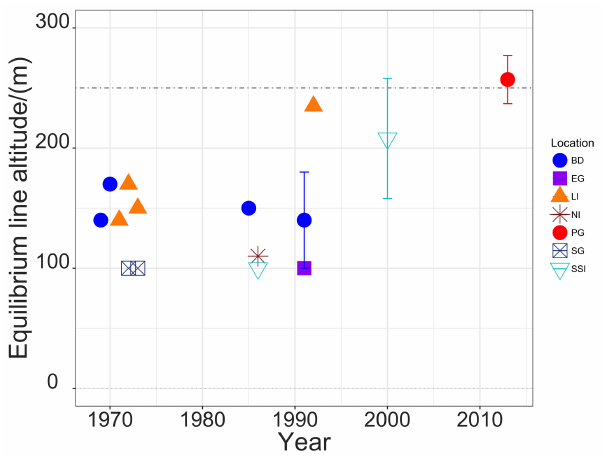
Figure 17. Equilibrium line altitude estimates from this study (PG) and former glaciological studies during the last decades. ELA es- timates taken from literature encompass: BD is Bellingshausen Dome, KGI (Orheim and Govorukha, 1982; Jiahong et al., 1994; Jiawen et al., 1995); EG is Ecology Glacier, KGI (Bintanja, 1995); LI is Livingston Island (Vilaplana and Pallàs, 1994; Molina et al., 2007; Navarro et al., 2009, 2013); NI is Nelson Island (Jiawen et al., 1995); SG is Stenhouse Glacier, KGI (Curl, 1980); SSI is South Shetland Islands (Serrano and López-Martínez,